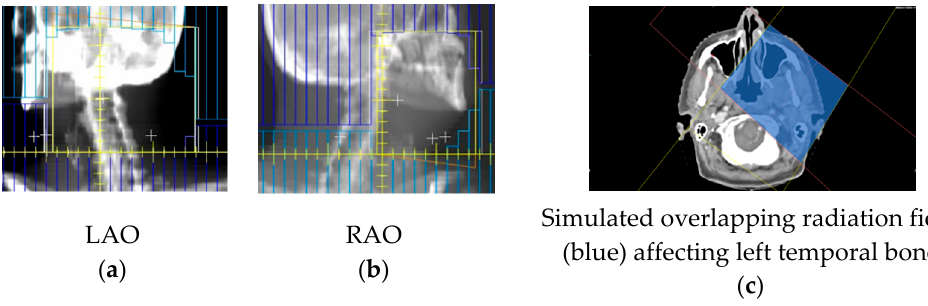
Figure 2. Upper radiation fields with 66 Gray (Gy) in 33 fractions to the left oropharynx tumor and neck. Radiotherapy was planned with 3D conformal radiotherapy, utilizing two fields to the upper volume: left anterior oblique (LAO) ( a ) and right anterior oblique (RAO) ( b ) fields, and the beam’s eye radiographs shown. These fields have been reconstructed on axial CT, to indicate the approximate volume ( c ). The area where the fields overlap (blue) received 66 Gy.